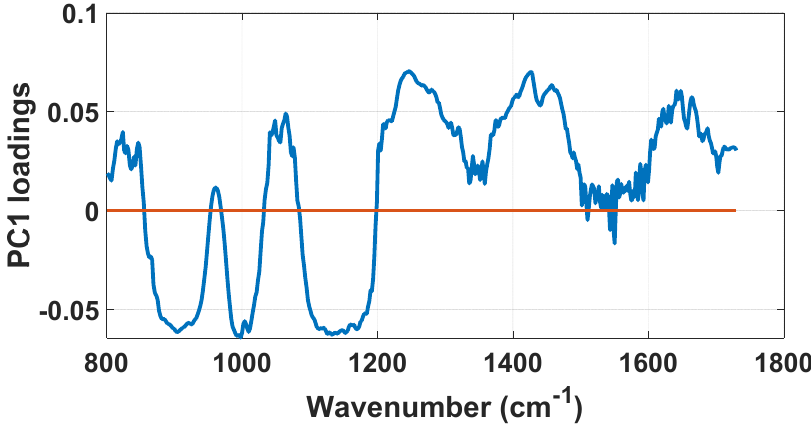
Figure 7. Wavenumber-dependent PC1 loadings (blue) and the zero line (red) for easier visualization of the absolute amplitude of loading values. Table 1. Vibrational modes assigned to peaks of absolute values of PC1 loadings [61].